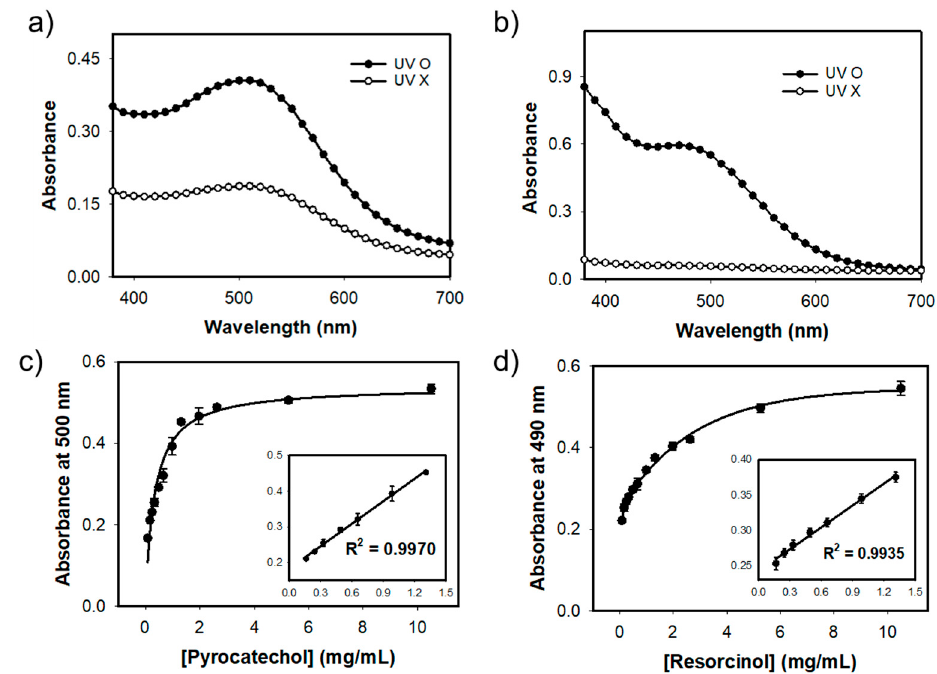
Figure 6. Effects of UV-light irradiation for the detection of ( a ) pyrocatechol and ( b ) resorcinol, and dose-response curve and calibration plot (inset) for ( c ) pyrocatechol and ( d ) resorcinol using UV-light-driven MgAC-Fe 3 O 4 /TiO 2 -based system.